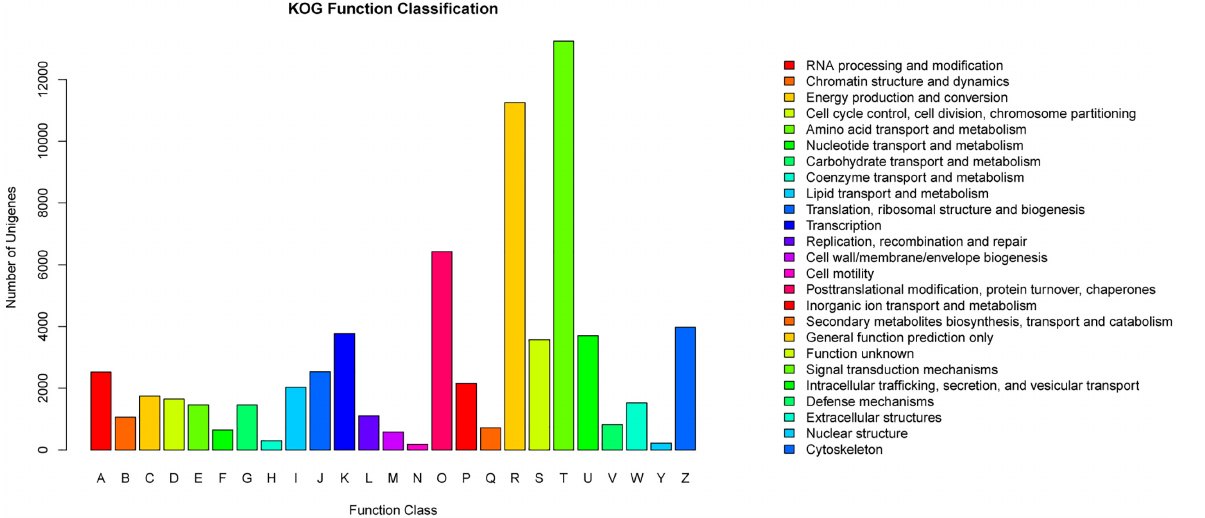
Fig 2. Histogram presentation of KOG classification. 60,593 sequences were grouped into 25 KOG categories. The information of right one-to-one correspond to every bar of left histogram.